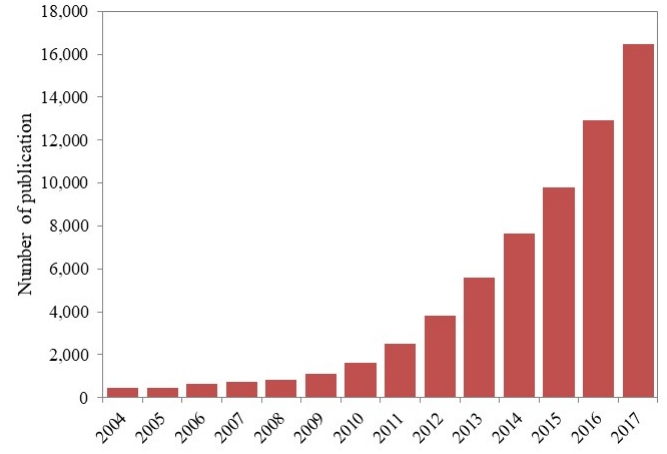
Figure 2. Publication trend in graphene chorology between 2004 and 2017 in Science ‐ Direct (this graph is plotted based on the simple searching of “graphene” at: www.sciencedirect.com).